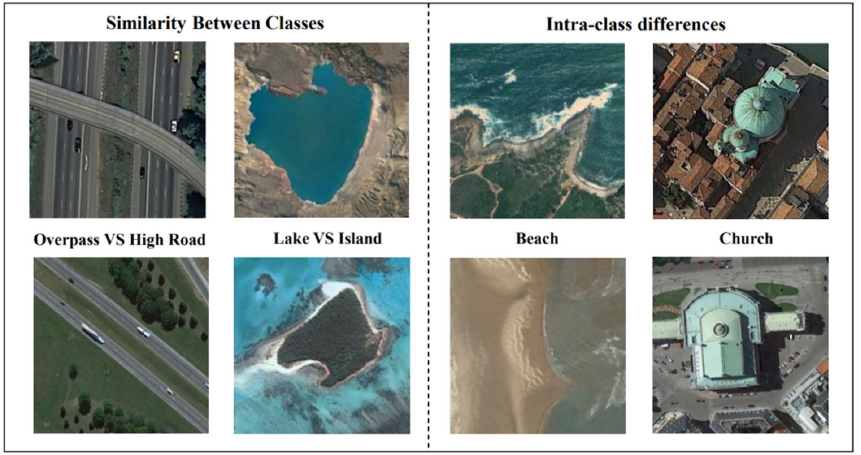
Figure 1. Similarity between categories and differences within categories of remote sensing images.